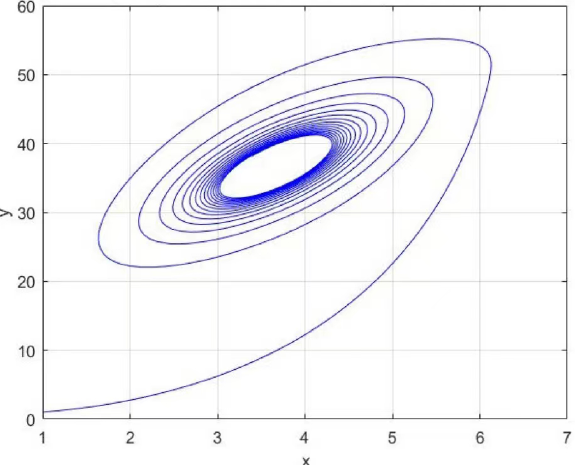
Figure 4. The bifurcating phase trajectory with